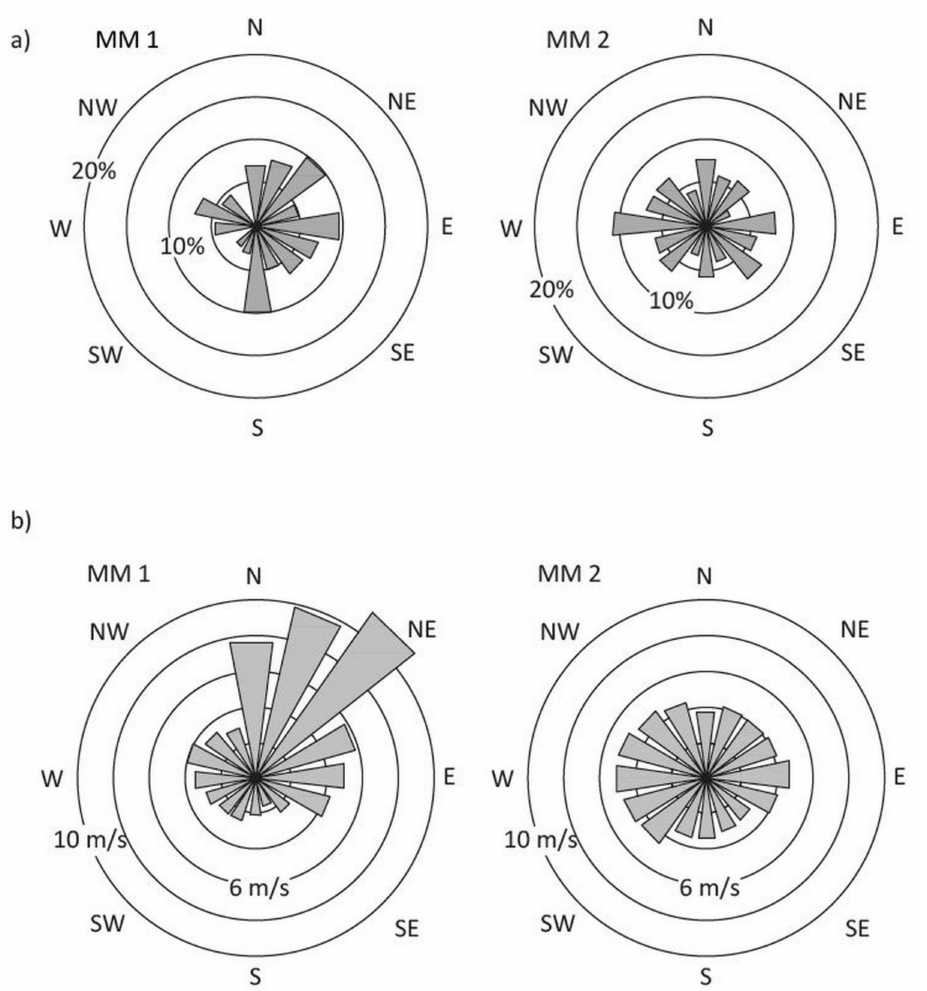
Figure 7. Distribution of ( a ) frequencies and ( b ) medium speed of wind direction at the observed meteorological stations for the periods 1998–2002 (for MM1) and 2000–2002 (for MM2) (adapted with permission from [43], Croatian Association of Civil Engineers,